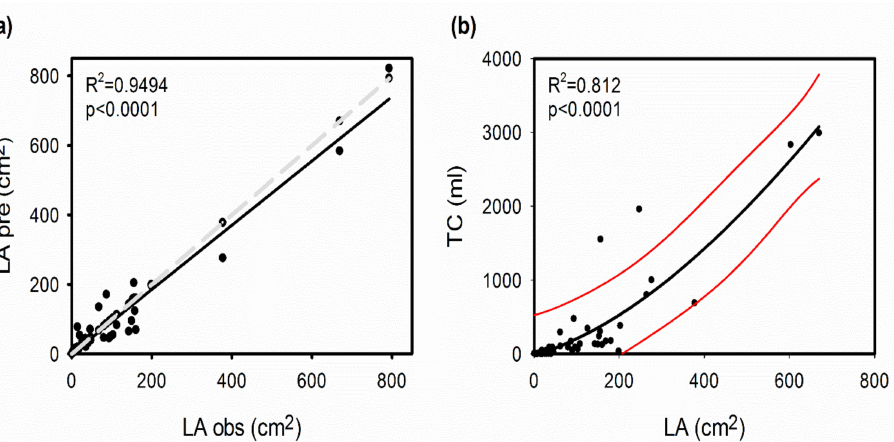
Figure 4. Regression models for tank capacity estimation. ( a ) Linear relationship between predicted leaf area (LA pre) and observed leaf area (LA obs). ( b ) Polynomial regression between tank water holding capacity (TC) and leaf area (LA). The broken line in ( a ) represents the 1:1 relationship between observed and predicted LA values, red lines in ( b ) represent 95% confidence